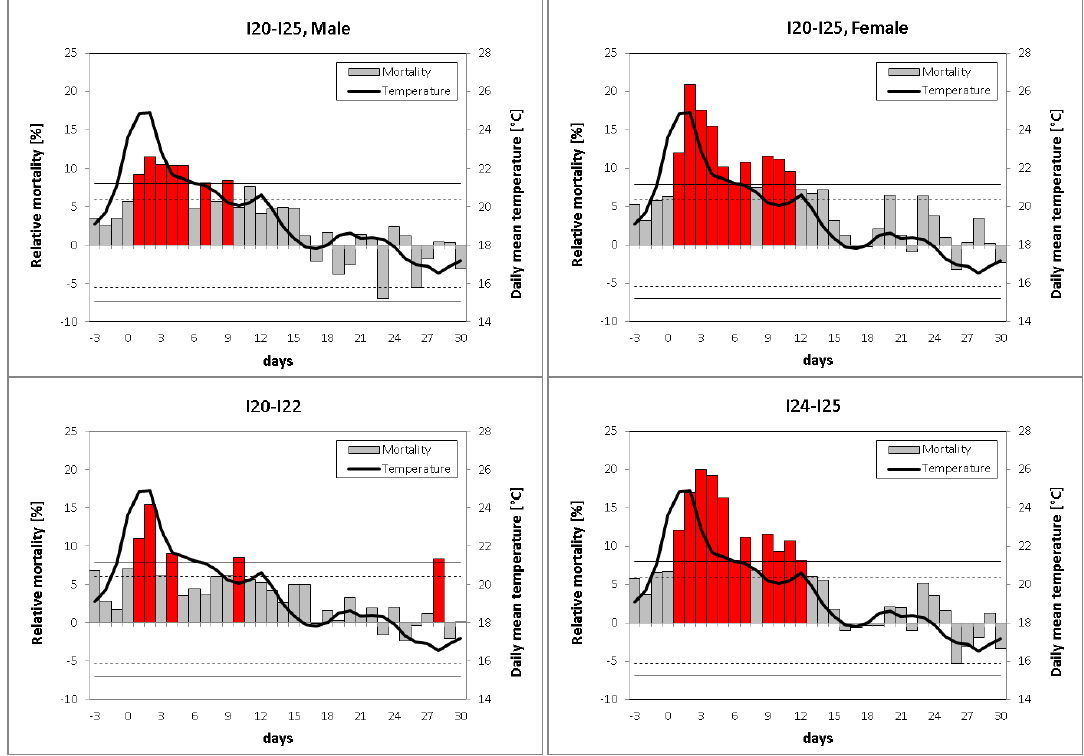
Figure 4. Mean relative deviations of IHD mortality for males ( top , left ), females ( top , right ), subtypes I20–I22 ( bottom , left ), and subtypes I24–I25 ( bottom , right ) for 34-day sequences of heat waves beginning from 3 days before up to 30 days after the onset of the heat waves. Solid (dashed) lines denote the 99% (95%) confidence interval obtained by the Monte Carlo method, highly significant relative deviations (α < 0.01) are colored in red.